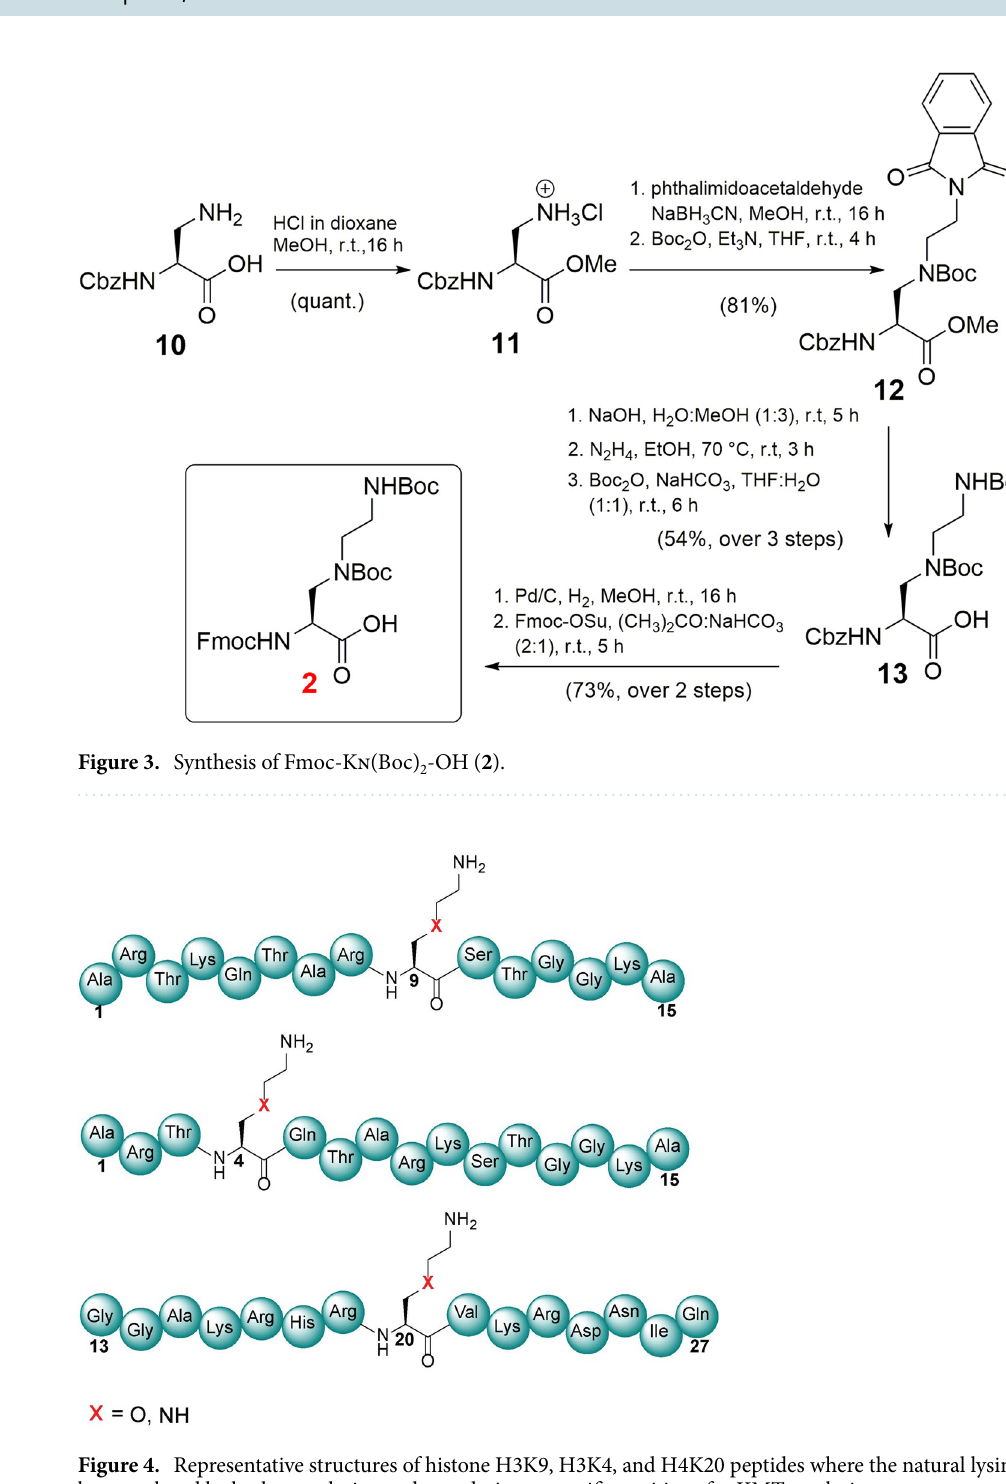
Figure 4. Representative structures of histone H3K9, H3K4, and H4K20 peptides where the natural lysine has been replaced by both γ-oxalysine and γ-azalysine at specific positions for KMT